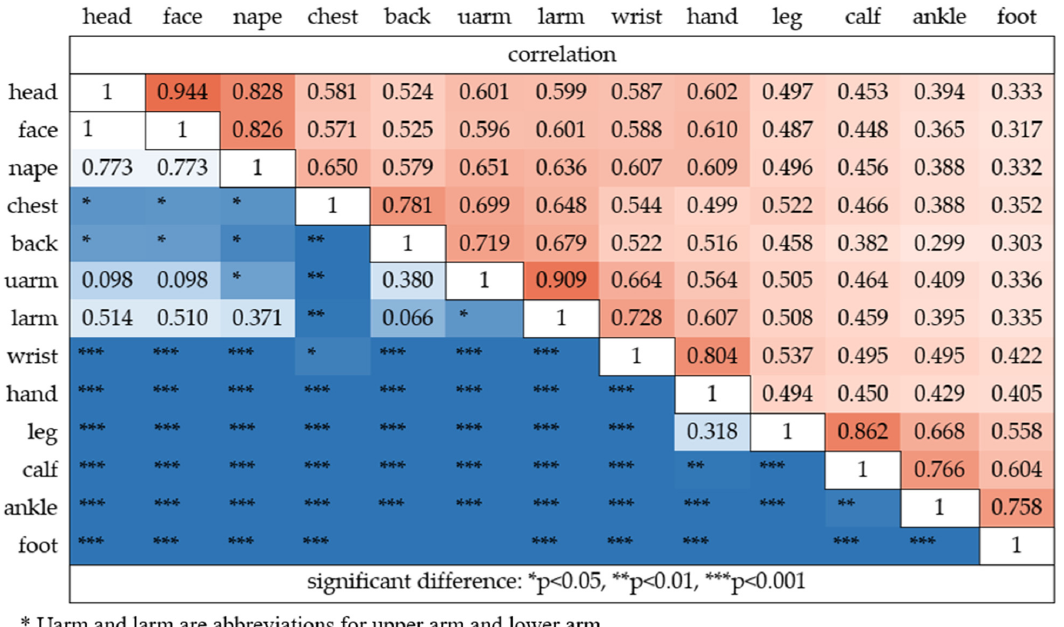
Figure 9. The Cohen’s kappa of the best combination . For example, the thermal preference of W1 could be predicted using five body parts (the face, nape, chest, wrist, and leg) with an accuracy of 0.97, Cohen’s kappa of 0.91, AUC 1 2 3 4 5 6 7 8 9 10 11 12 130.500.600.70 0.80 0.901